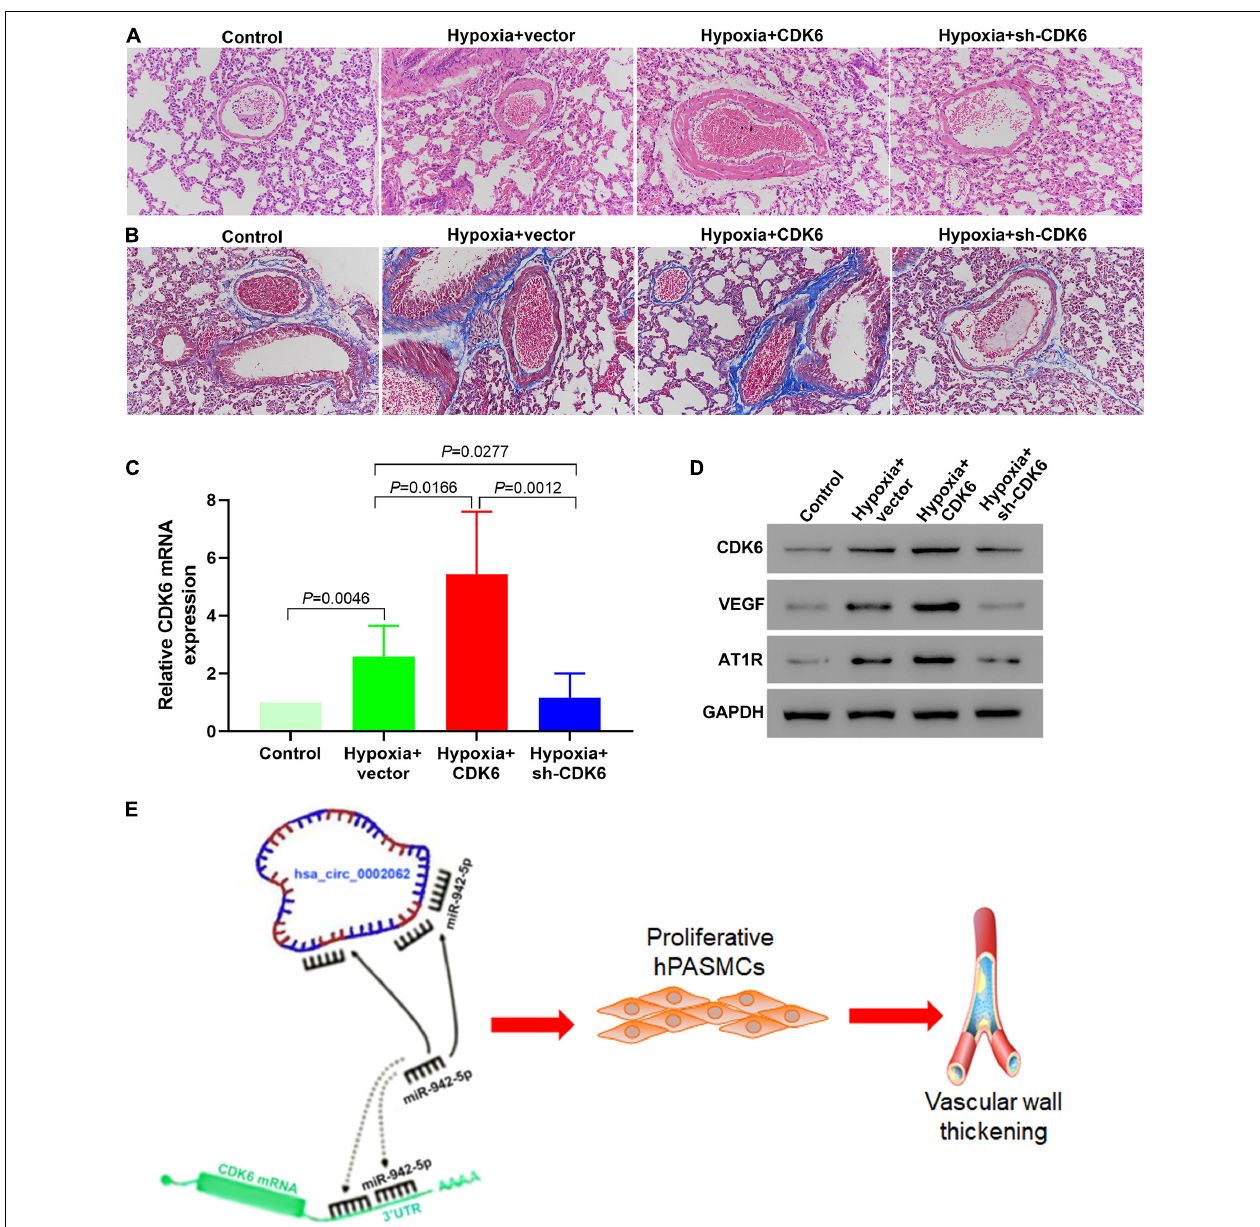
FIGURE 6 | Low Expression of CDK6 in mice retarded pulmonary vascular remodeling in the development of murine HPH. (A) HE staining demonstrating that knockdown of CDK6 with shRNA decreased the thickness of the pulmonary artery wall in mice. In contrast, transfection with a CDK6-overexpression plasmid had the opposite effect. (B) Masson’s trichrome staining revealing that upregulated CDK6 expression increased collagen fiber precipitation in the pulmonary artery wall of mice, while down-regulation of CDK6 expression did not. (C) The expression of CDK6 mRNA in the pulmonary arteries of mice in different groups by qRT-PCR. (D) Protein expression levels of CDK6, VEGF and AT1R in the pulmonary arteries of mice in each group by Western blot. (E) As illustrated in the schematic diagram, hsa_circ_0002062 functions as an endogenous hsa-miR-942-5P sponge to sequester and inhibit hsa-miR-942-5P activity and increase CDK6 expression, which resulted in hPASMCs proliferation and pulmonary vascular wall thickening. Error bars represent the mean ± SD from triplicate experiments. Image magnification: × 200.